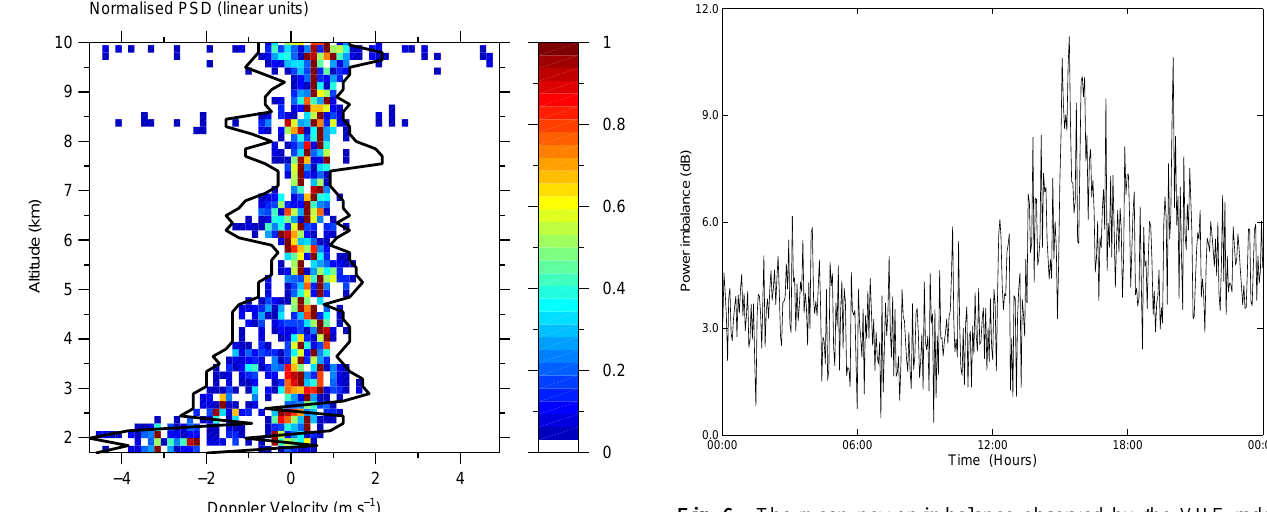
Fig. 6. The mean power imbalance observed by the VHF radar between the vertical and the six degree off-vertical beams averaged over the region 2 to 4km for observations made on 17 May